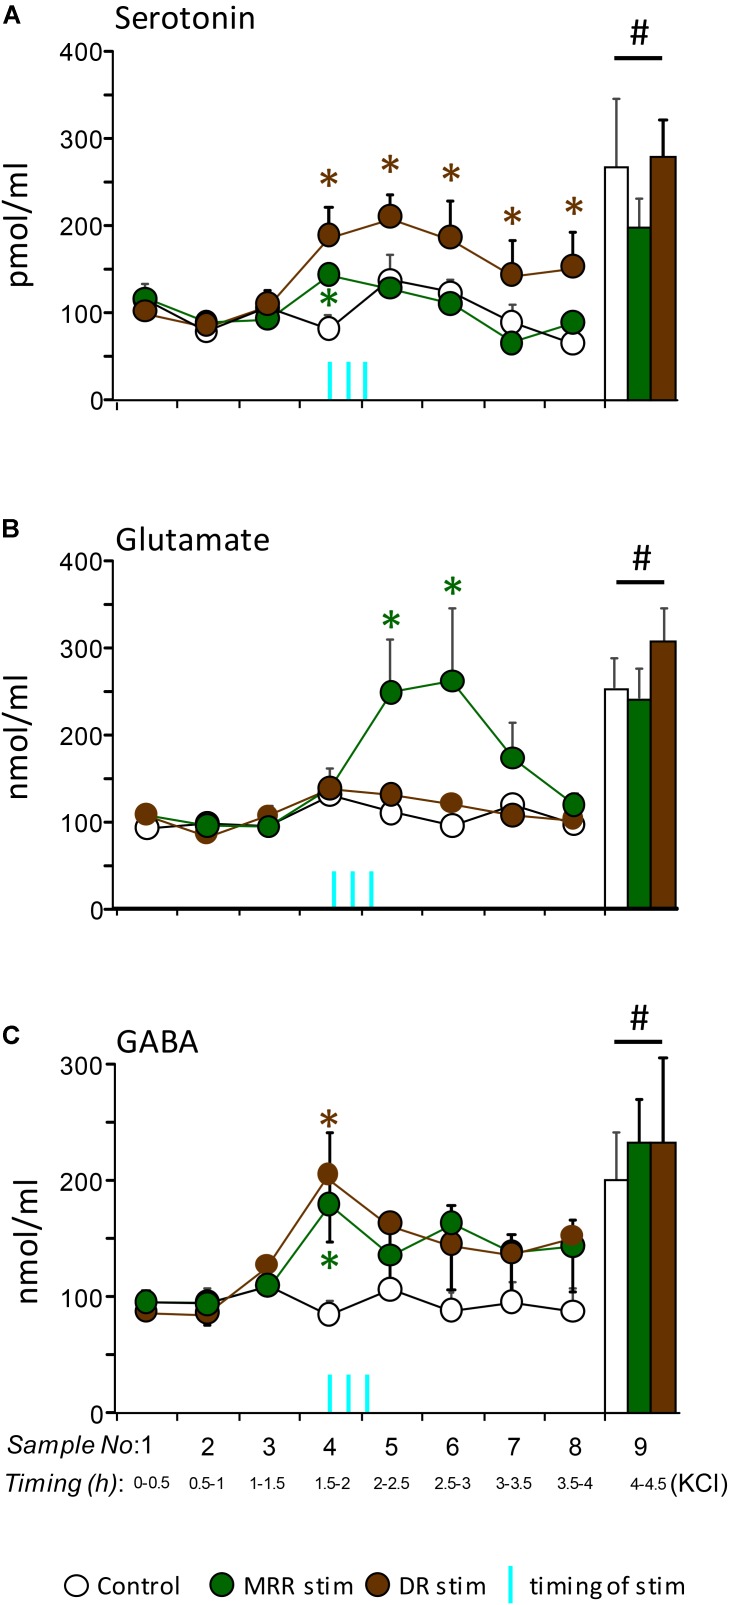
In vivo release of serotonin (A), glutamate (B), and GABA (C) in the prefrontal cortex of mice stimulated optogenetically in their raphes (median raphe region, MRR; dorsal raphe, DR). The stimulation protocol was identical with that employed for behavioral studies. Vertical blue lines, the timing of stimulations. Note that the first stimulation was started 90 min after the last basal sampling and 15 min before the fourth sampling, whereas the third stimulations started right at the beginning of the fifth fraction. Sample sizes: control n = 6; MRR stimulation n = 9; DR stimulation n = 5. Vertical columns at the right-hand side of graphs, neurotransmitter responses to the infusion of KCl into the raphes. DR, dorsal raphe; MRR, median raphe region; ∗significant effect of stimulations compared to control levels, same time-point; #significant effect of KCl infusion as compared to baseline levels (the first three time points of each curve).